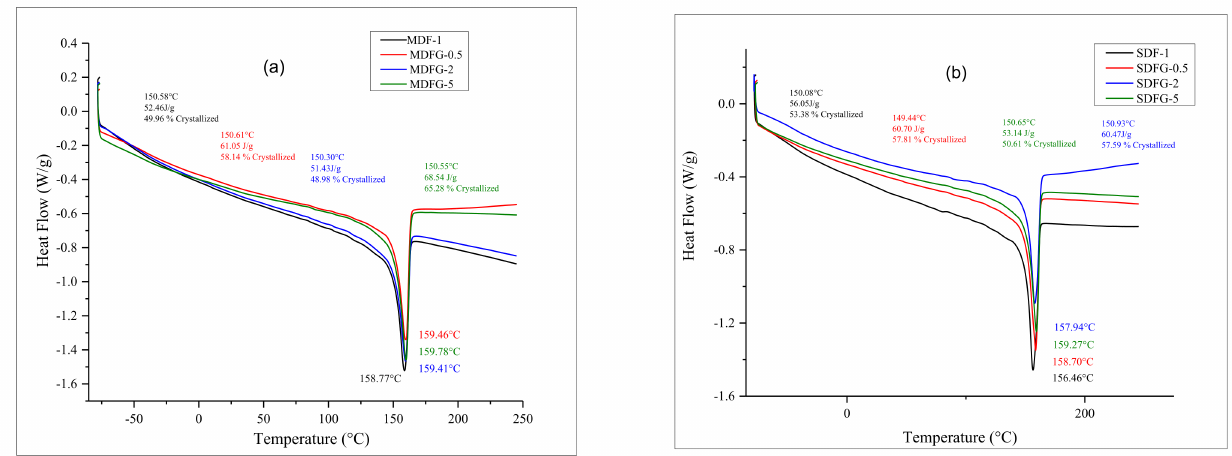
Figure 6. Overlay graphs of DSC of nanocomposites prepared by: ( a ) melt-mix method, and ( b ) solution-cast method.